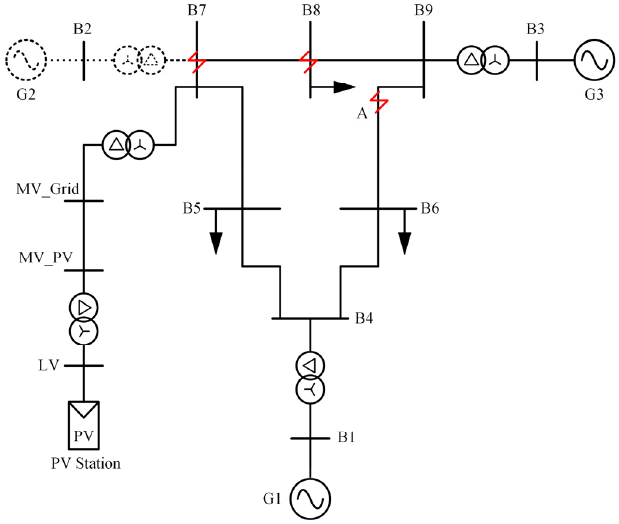
Figure 5. Simulink model of Power system with high PV penetration. Table 1. The capacity and active power output of each power source during normal operation.